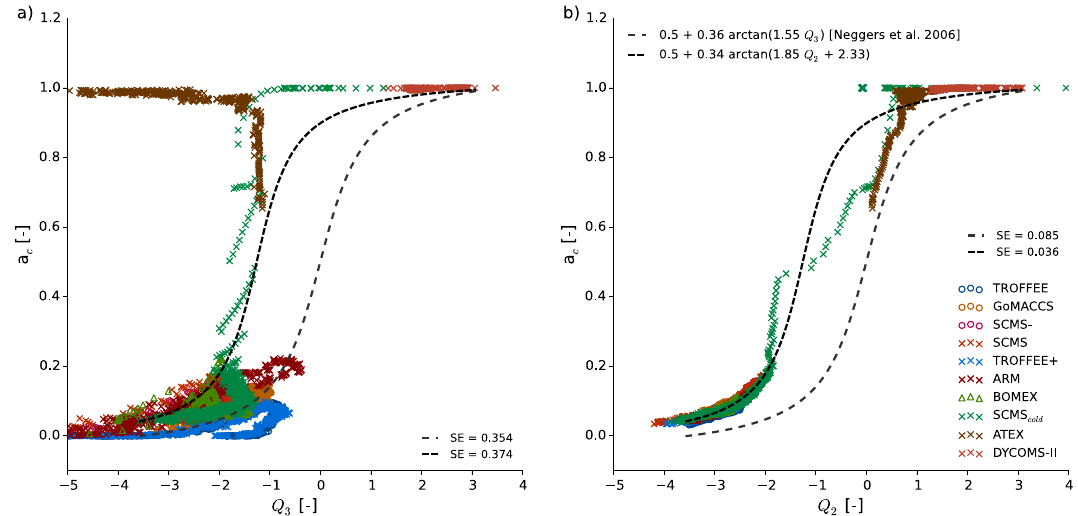
Figure 3. Area fraction of clouds as (a) a function of the normalized saturation deficit ( Q 3 ; Eq. 6) as described in Neggers et al. (2006) and (b) as a function of the normalized saturation deficit at cloud base ( Q 2 ; Eq. 5). Negative Q 2 and Q 3 values indicate ShCu clouds, while positive values denote stratocumulus clouds. The dashed lines indicate the parameterizations based on Q 3 and Q 2 . SE represents the residual standard